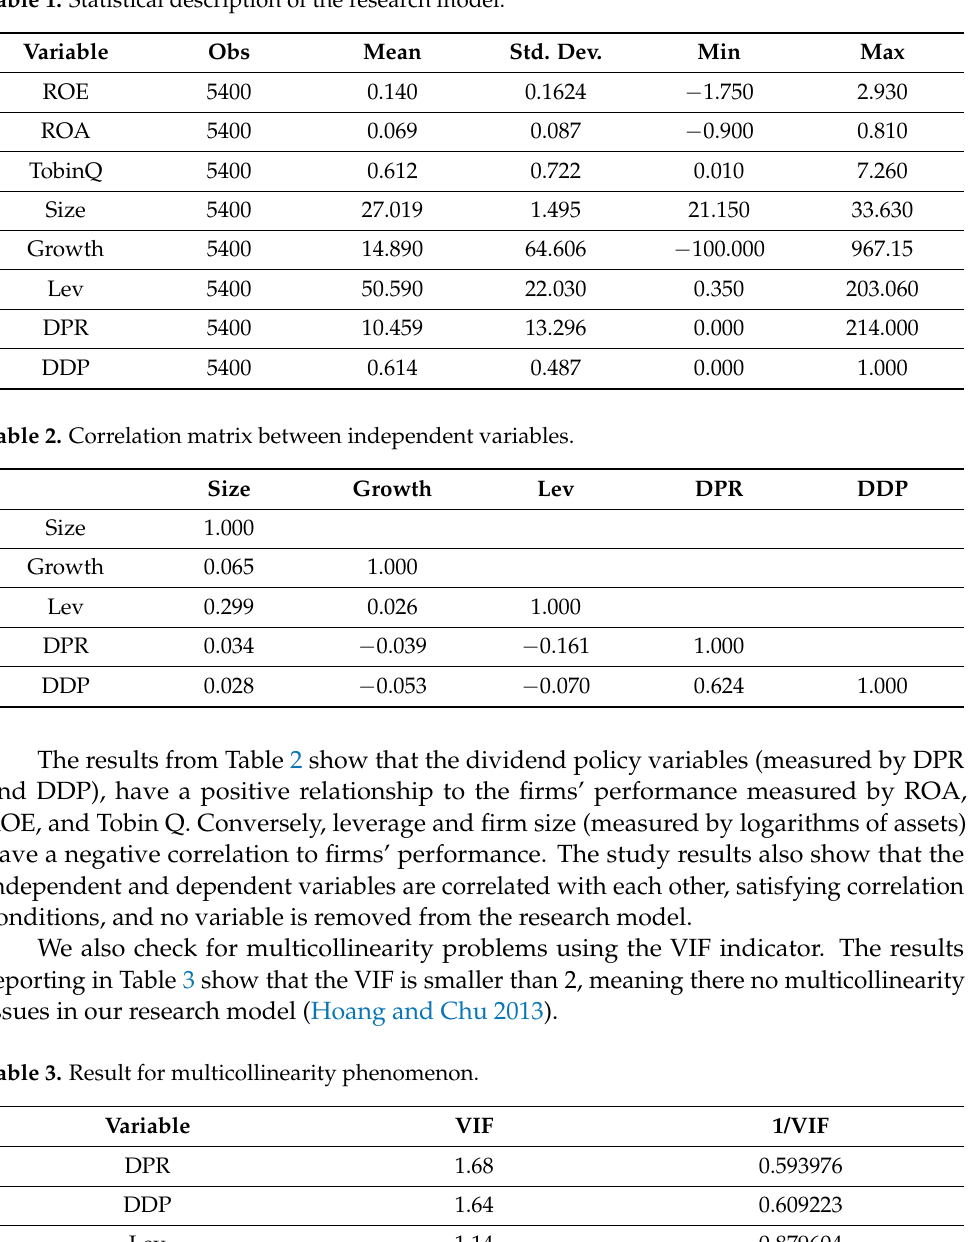
Table 1. Statistical description of the research model.